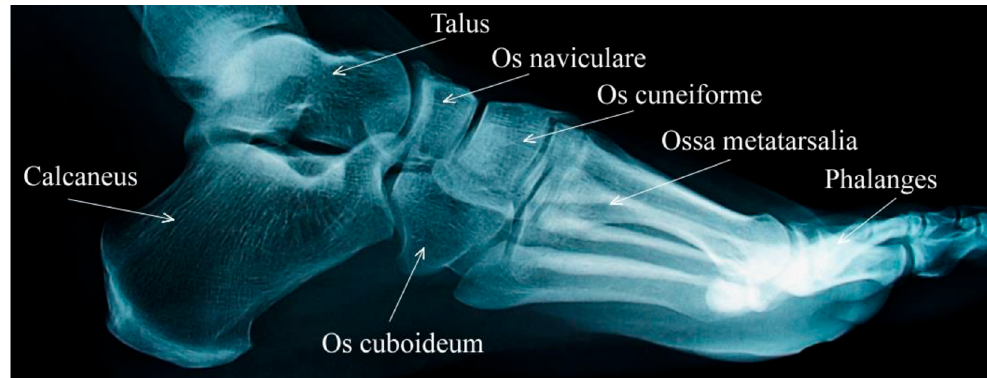
Figure 1. X-ray of the foot.